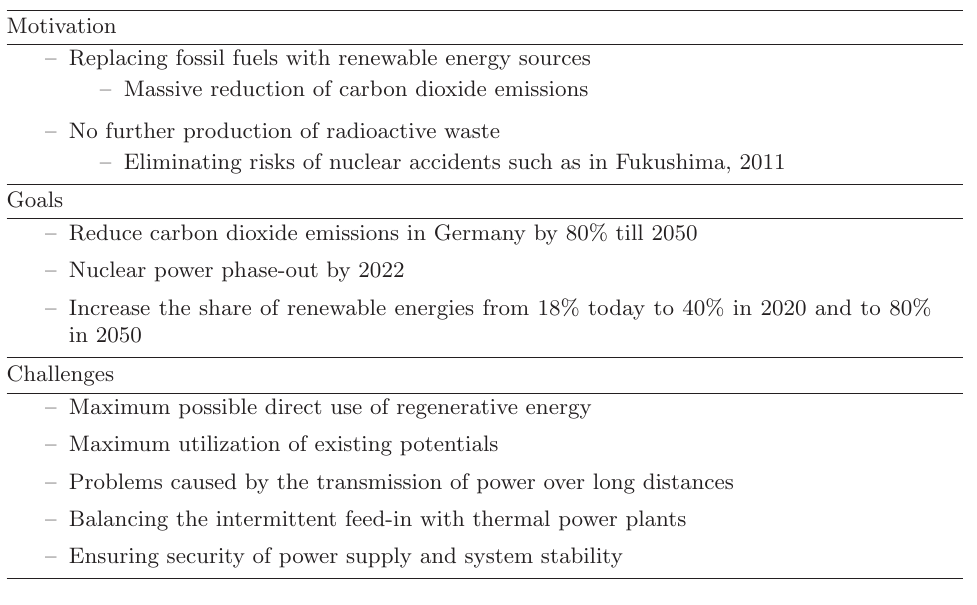
Table III. – Incentives, goals and future challenges for the energy sector of